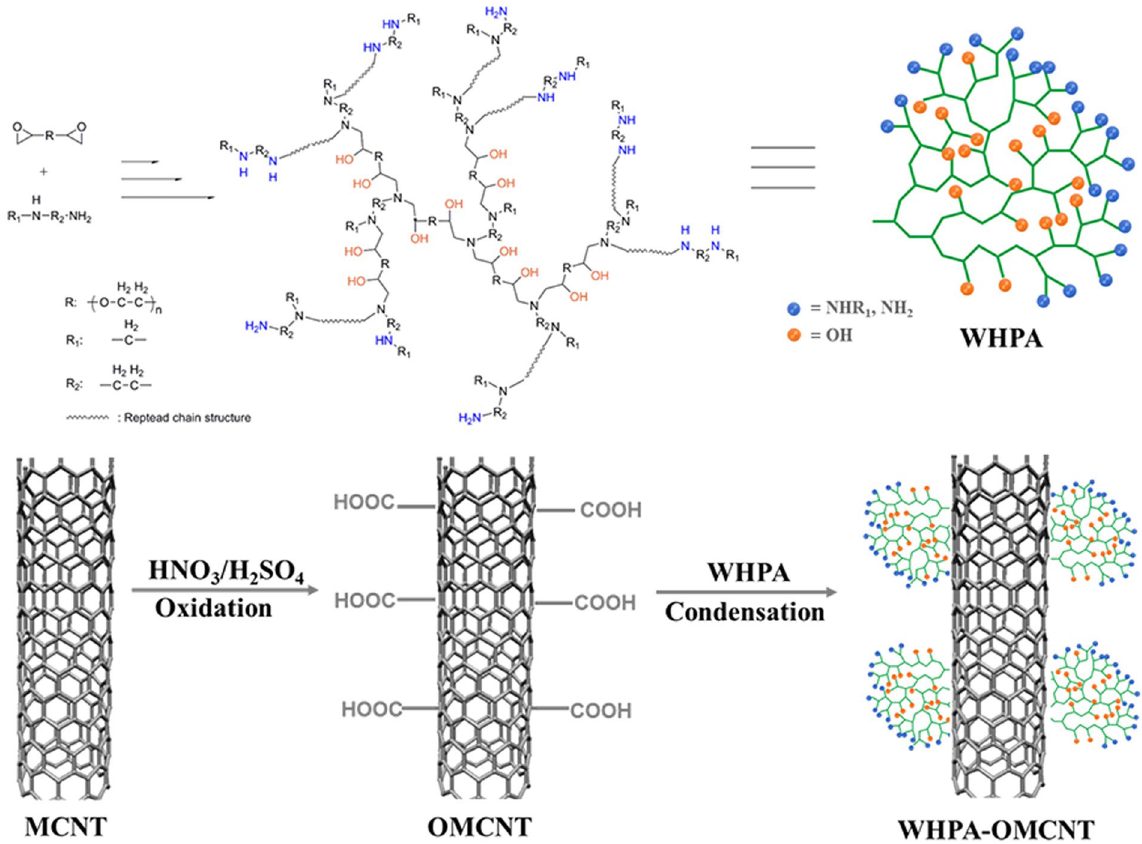
Figure 1. The preparation process of WHPA-OMCNT